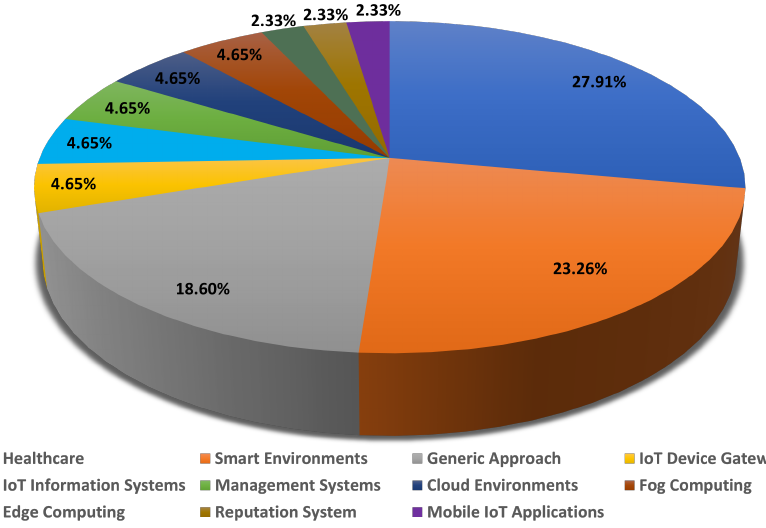
Figure 5. Article distribution of the included studies by target